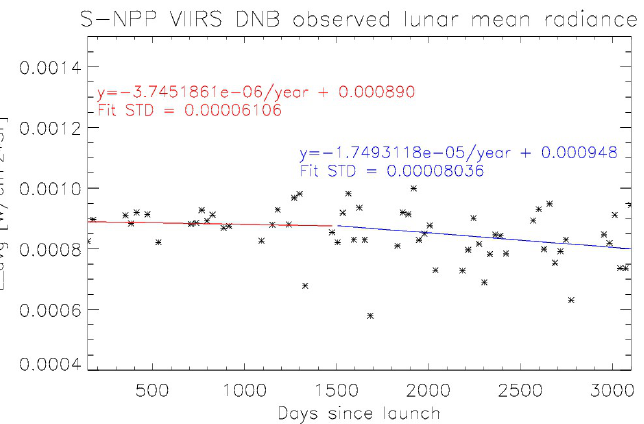
In each pixel of the moon, the right detector bias value is found from the DN0 LUT. If The FWHM of the modulated RSR has been reduced over the lifetime. The RTA dark- 280 the pixel is HGS or MGS, the gain ratio of the detector is chosen from the gain ratio LUTs. ening did not affect the shape of the RSR near the left side lobe near 500 nm in Figure 7a. 281 The corresponding LGS gain is interpolated from the LGS gain LUTs as shown in Figure 8a. However, on the right side of RSR around 900 nm, there was significant RTA darkening, 282 The mean lunar radiance is measured and shown in Figure 9. gradually reducing the response over time as shown in Figure 7b. As a result of the RSR 283